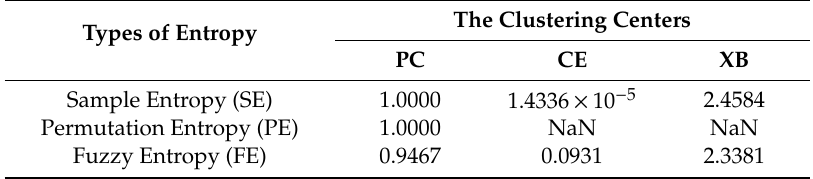
Table 5. GG clustering index based on ensemble empirical mode decomposition